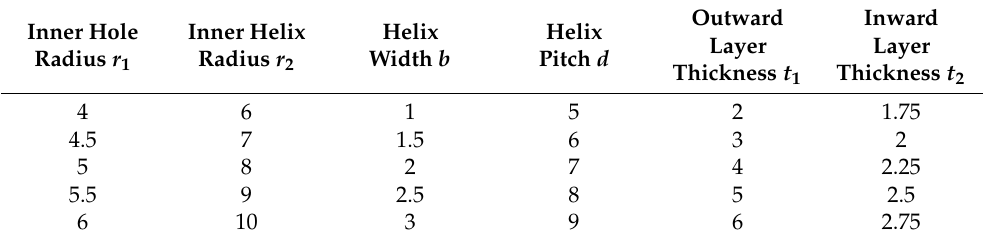
Table 3. Geometric parameters for chamber structure (unit: